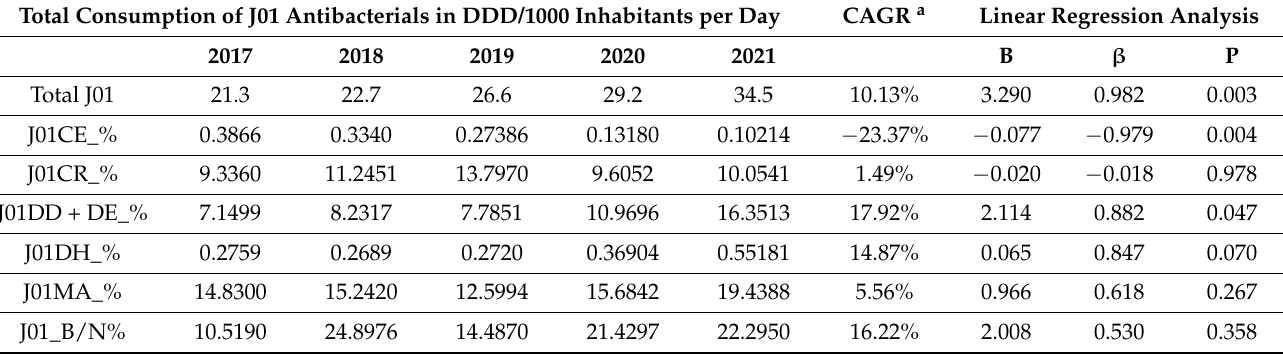
Table 1. Changes in the quality indicators in Serbia from 2017 to